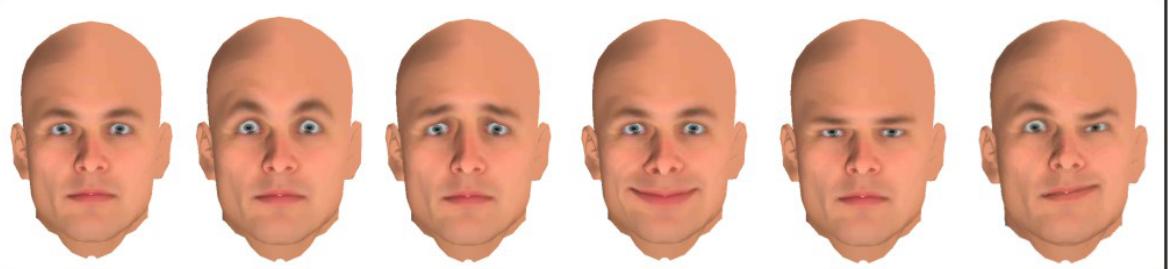
Figure 22. Expressions applied in the base model.